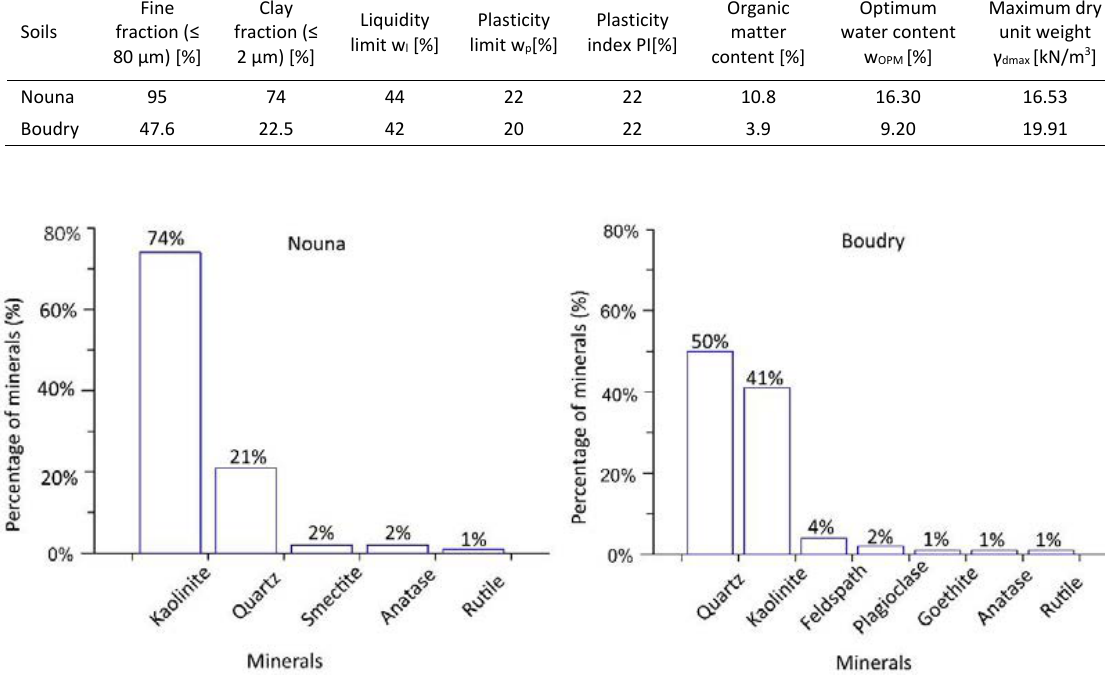
Fig. 2: Mineralogical composition of the fine fraction of the studied soils